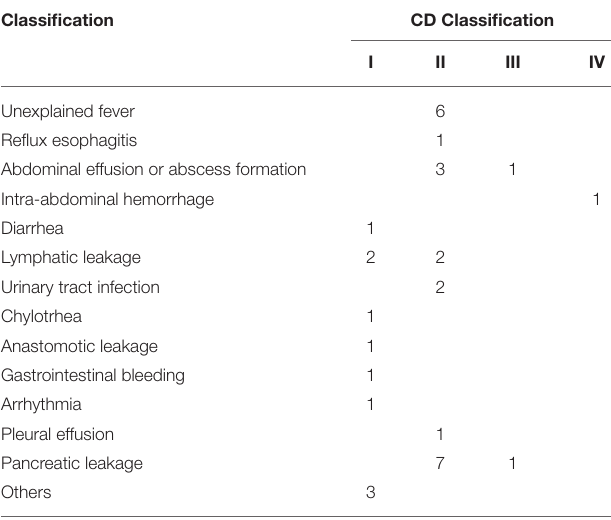
TABLE 2 | Classification of postoperative complications in the preoperative chemotherapy